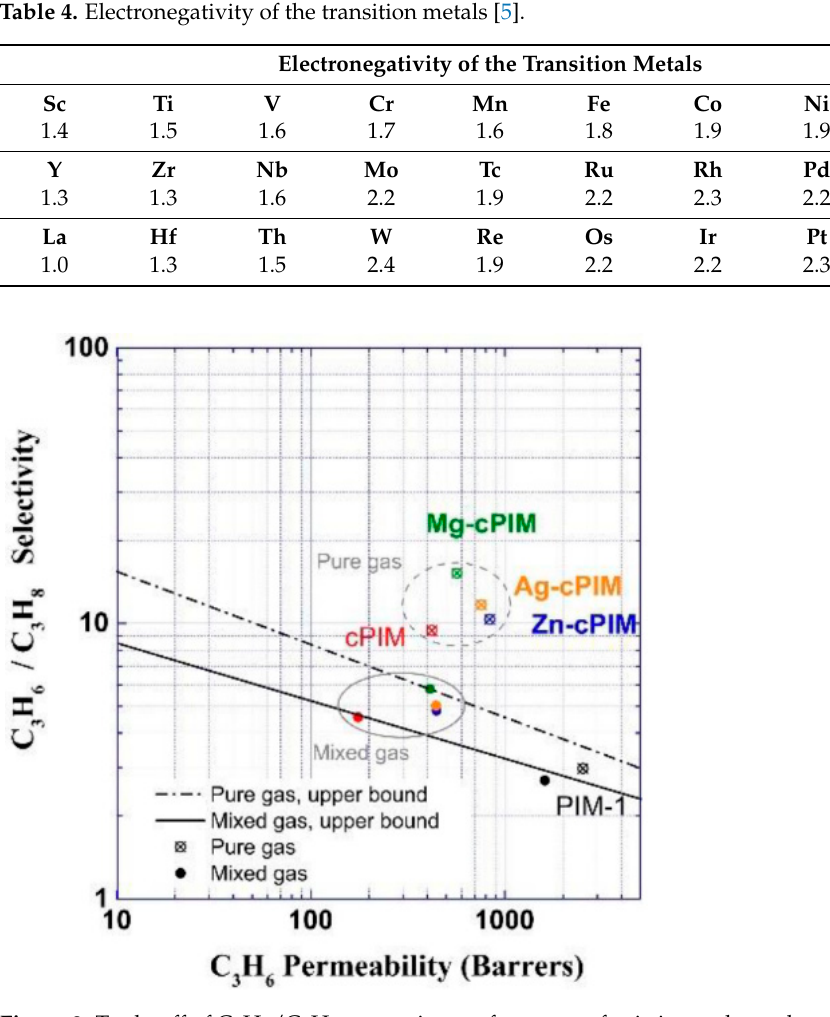
Figure 2. Trade-off of C 3 H 6 /C 3 H 8 separation performance of pristine and metal-modified polymer of intrinsic microporosity (PIM) membranes [22].